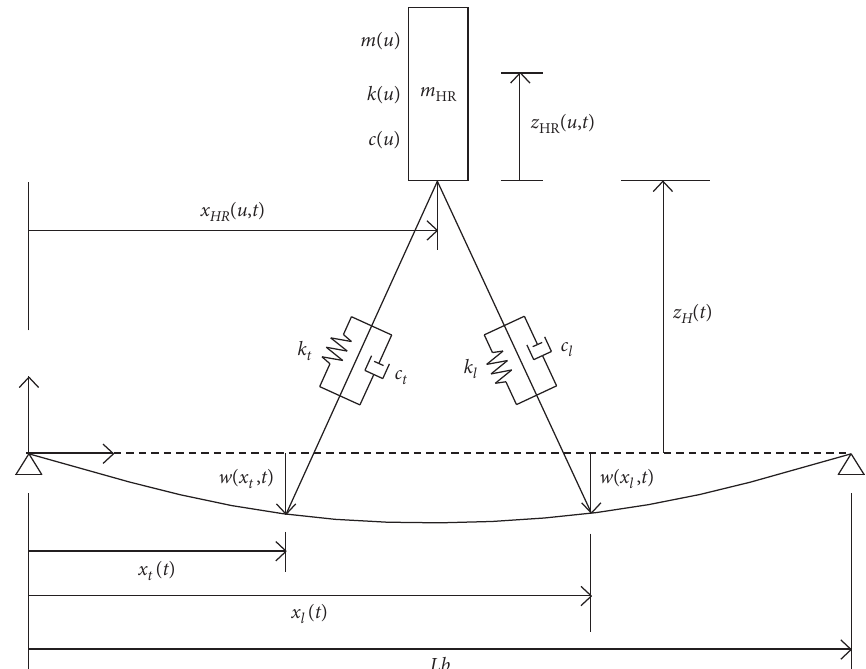
Figure 1: Human-structure interaction bipedal model with the